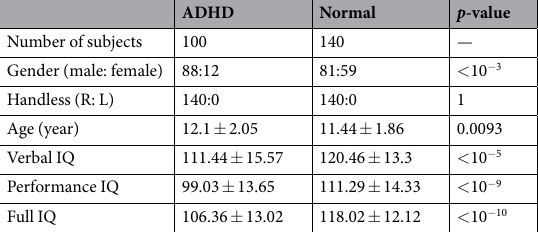
Table 5. Subjects’ demographic and covariate